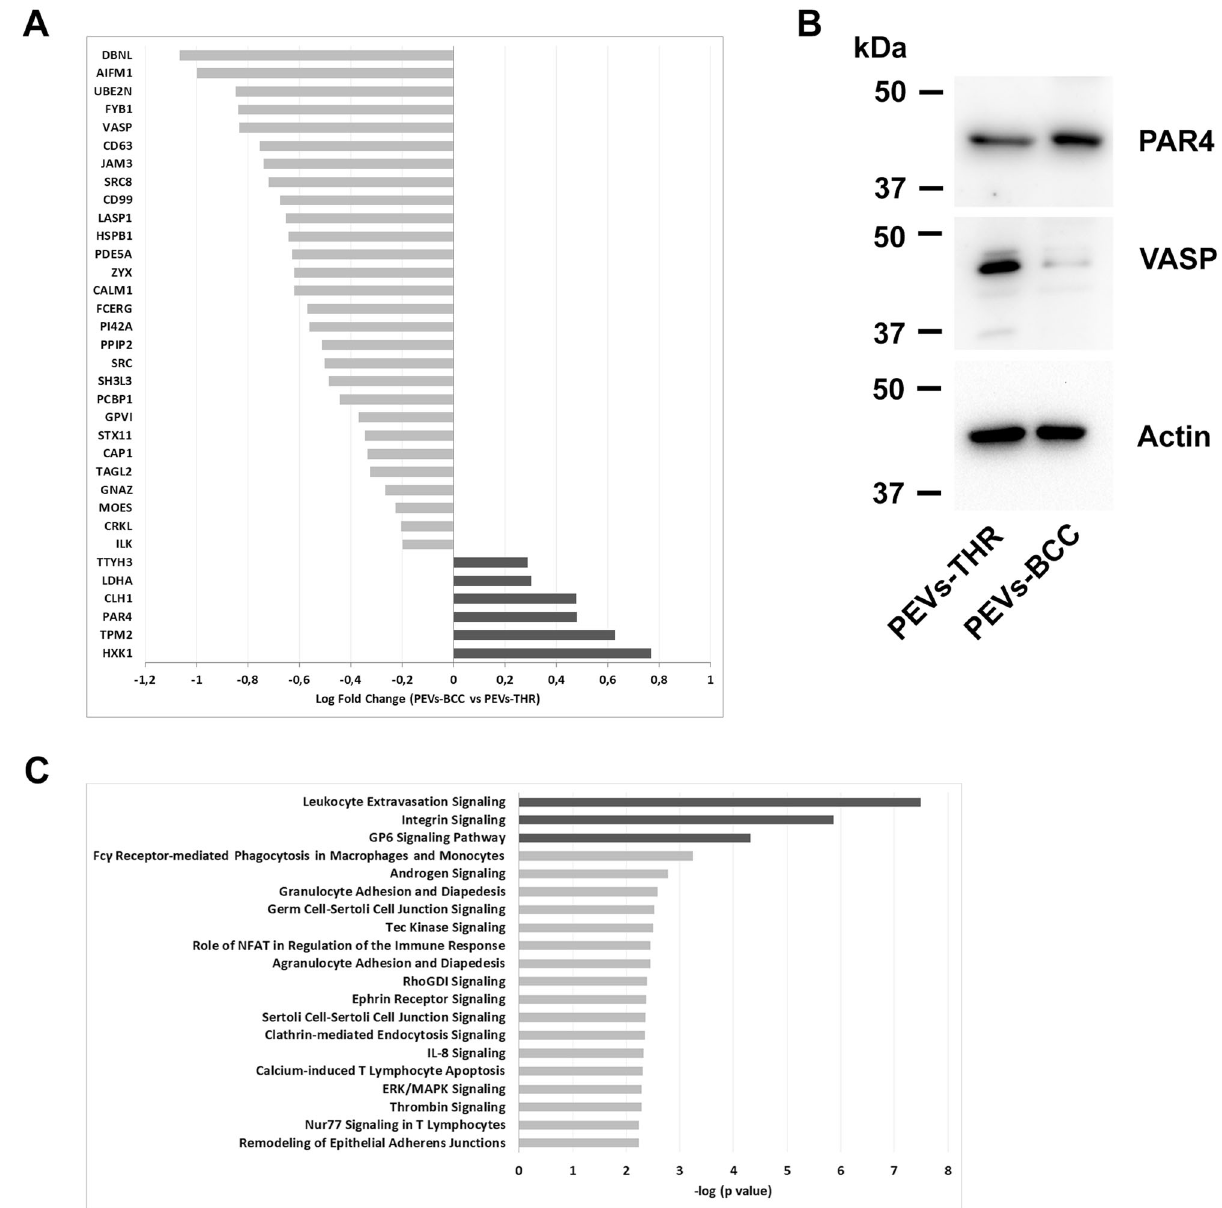
Fig. 4 Quantitative proteomic and gene ontology enrichment analysis. A Protein quanti fi cation in PEVs populations by LC-MS. The Log Fold Change indicates the difference of single protein expression in PEVs-BCC vs PEVs-THR. The dark gray bars indicate proteins more represented in PEVs-BCC, conversely light gray bars shown proteins more enriched in PEVs-THR. B Immunoblotting analysis of PAR4 and VASP in PEVs-THR and PEVs-BCC. Actin staining was performed as control for equal loading. C Gene ontology enrichment analysis of the PEVs proteins involved in the regulation of speci fi c biological processes. The 20 pathways that, according to the bioinformatic analyses, displayed the most signi fi cant protein enrichment are reported. The dark gray bars indicate pathways that were predicted to be inhibited by PEVs-BCC compared to PEVs- THR, whereas light gray bars indicate processes that are likely to be modulated although no prediction was